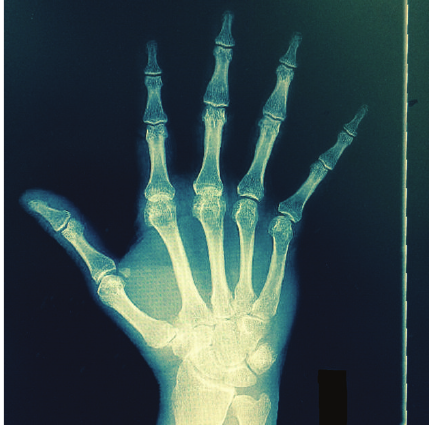
Figure 4: Right windblown